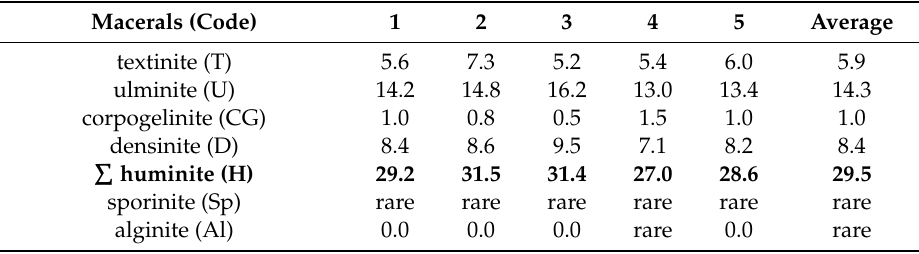
Table 3. The petrographic composition of coaly shale. Summary percentages of each group of macerals and other petrographic components (minerals) are indicated in